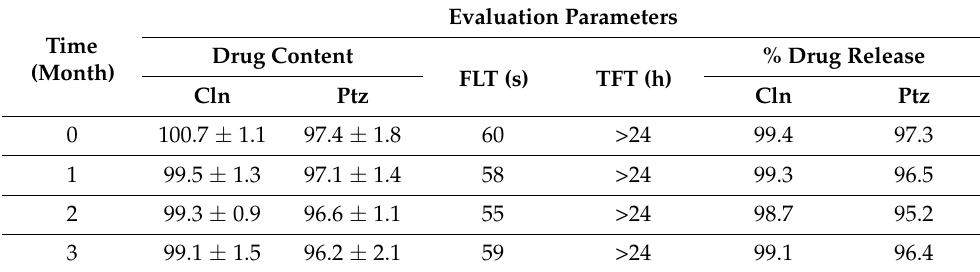
Table 5. Stability studies of formulation